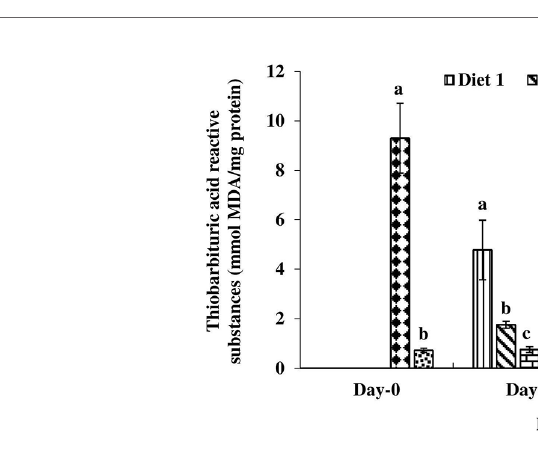
FIGURE 4 | Thiobarbituric acid reactive substance level found in four different diets fed UV-B exposed and unexposed Catla catla . Bars with different superscripts (a-e) are signi fi cantly different (n